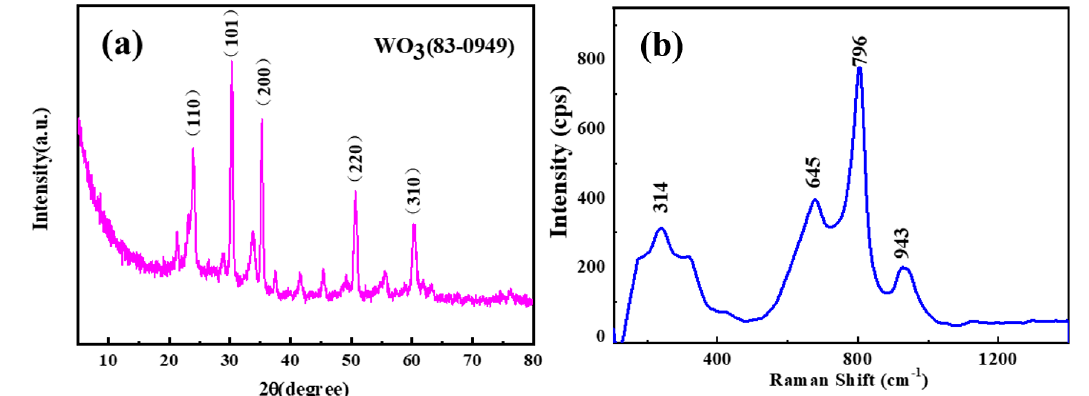
Figure 1. ( a ) XRD pattern and ( b ) Raman spectrum of the synthesized products. Figure 1 . ( a ) XRD pattern and ( b ) Raman spectrum of the synthesized products.